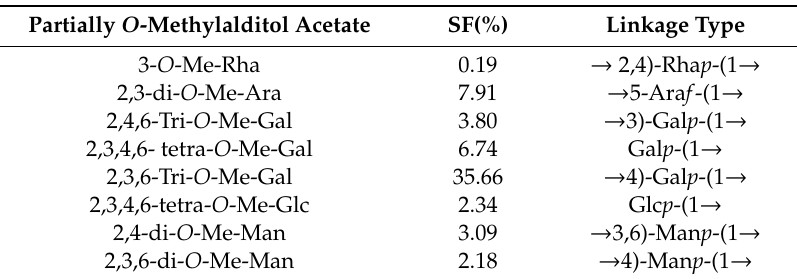
Table 4. Results of the main methylation analysis of PCp-I.